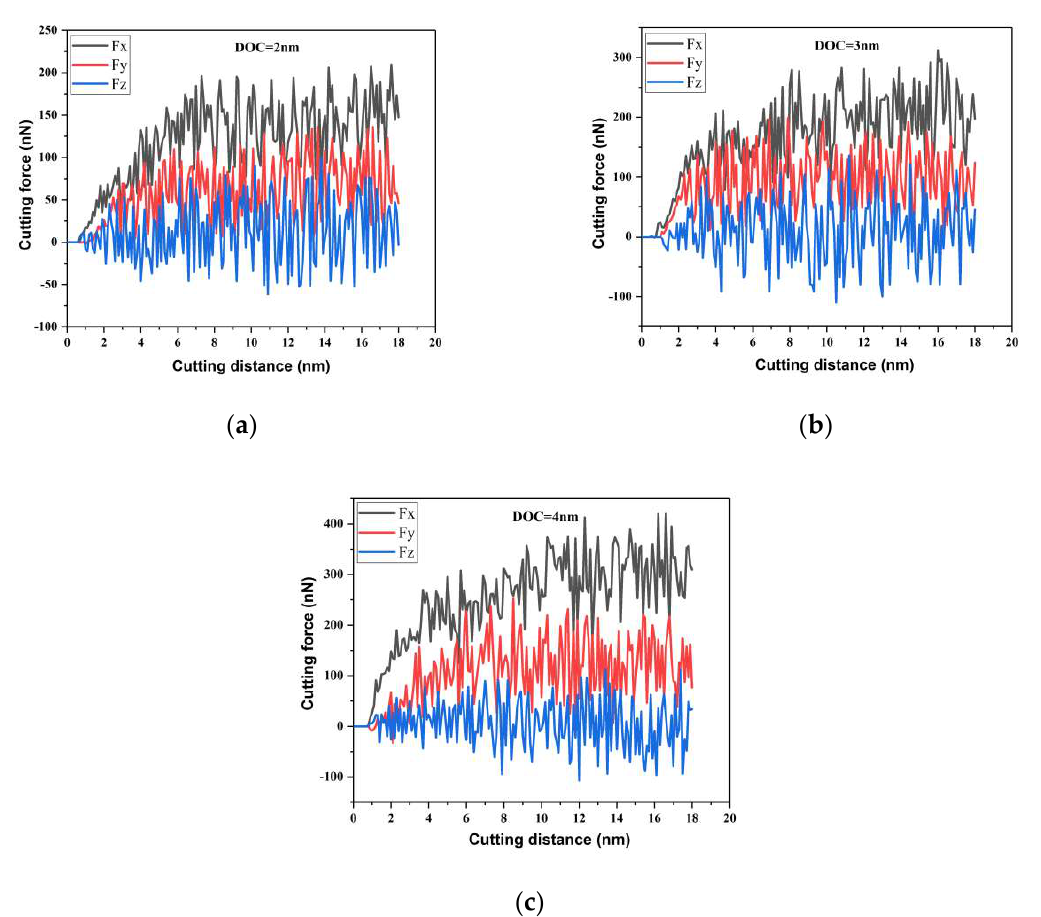
Figure 3. Cutting force at different cutting depths with water medium (( a ) cutting depth is 2 nm ( b ) cutting depth is 3 nm ( c ) cutting depth is 4 nm).